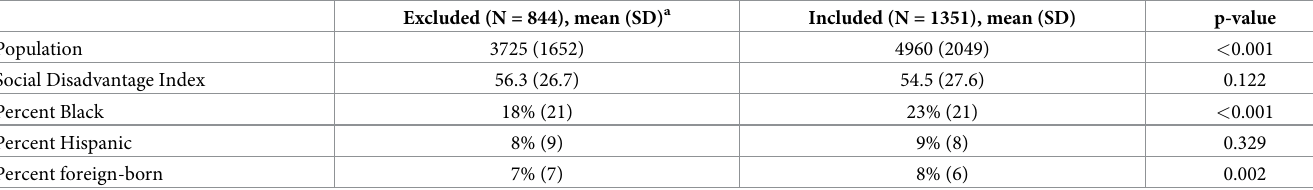
Table 1. Demographic summary of North Carolina census tracts that were included versus excluded from analysis.